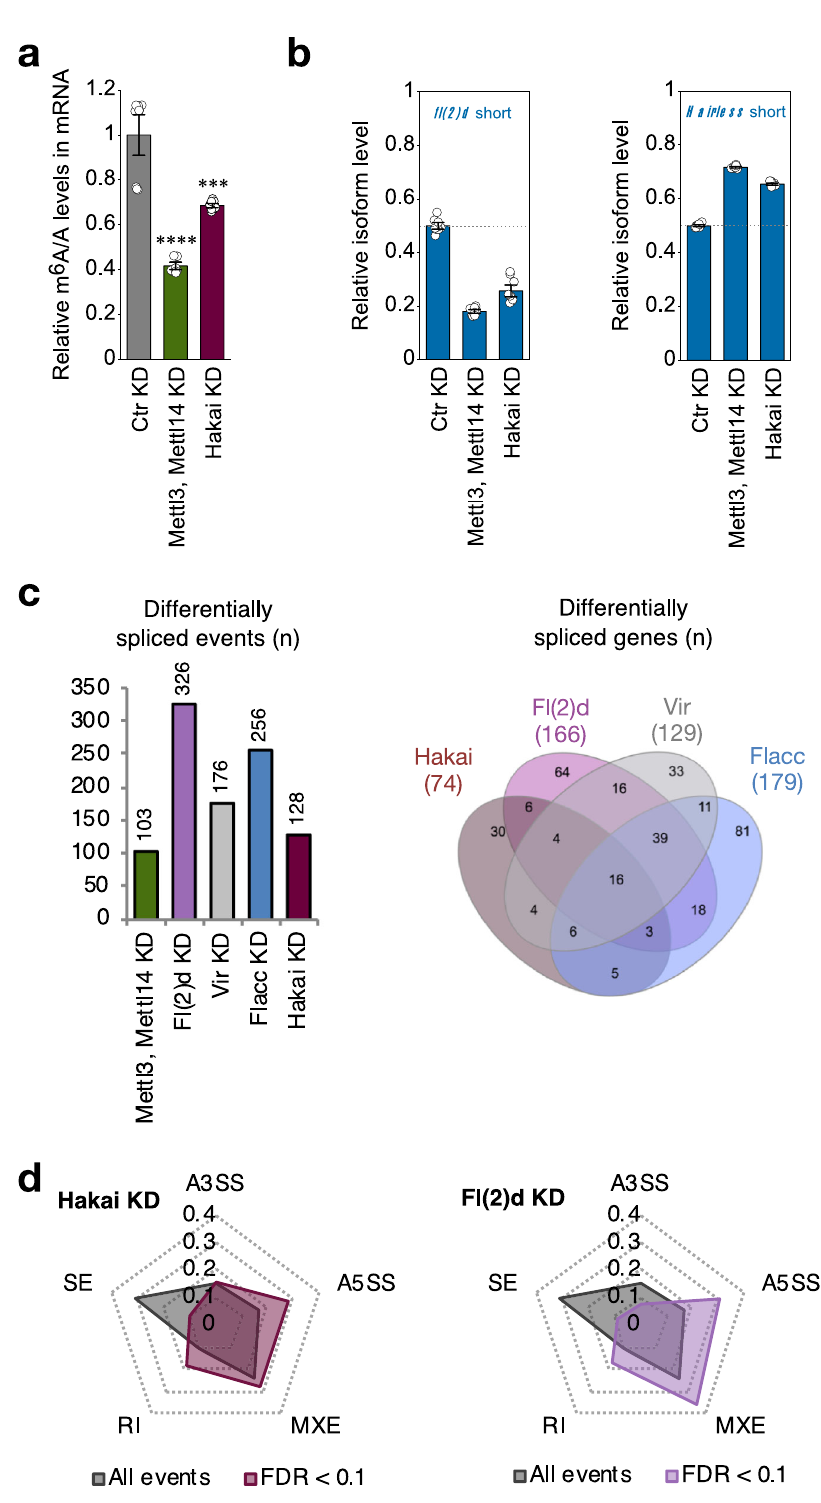
Fig. 4 Hakai regulates m 6 A levels and m 6 A-dependent splicing events. a LC – MS/MS quanti fi cation of m 6 A levels in either control samples or mRNA extracts depleted for the indicated proteins in S2R + cells. The bar chart shows the mean with standard error (SE) of three biological replicates and three technical measurements. KD of Hakai results in substantial reduction of m 6 A levels. ∗∗∗ P = 7.49E − 04 (Hakai KD), ∗∗∗∗ P = 7.51E − 06 (Mettl3, Mettl14 KD). Unpaired two-tailed Student ’ s t -test for unequal variances. b Relative isoform quanti fi cation of m 6 A-regulated genes ( fl (2)d and Hairless ) upon depletion of the indicated components. The bar chart shows the mean with standard error (SE) of three biological replicates and three technical measurements. Hakai is required for m 6 A-dependent splicing regulation. c Number of differentially spliced events upon knockdown of the indicated proteins (left) and common differentially spliced targets (right) (FDR < 0.1). d Radar charts display relative distribution of differentially spliced events upon knockdown of Fl(2)d and Hakai. Alternative 5 ’ splice site (A5SS) selection and intron retention (RI) are overrepresented events upon loss of m 6 A writer components. Source data for m 6 A measurement, qPCR and RNA-seq are provided as a Source Data fi le.